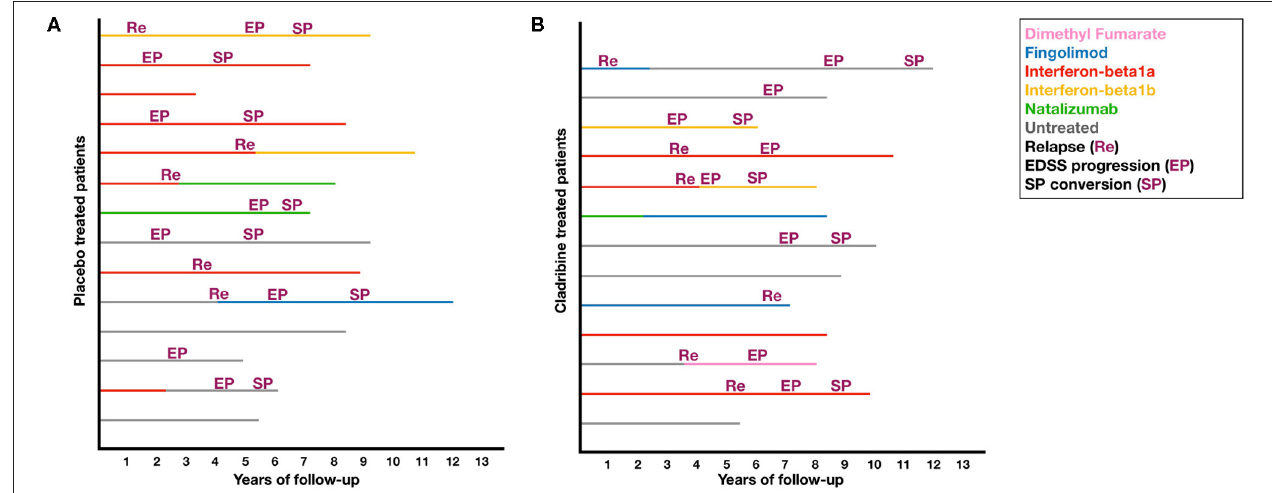
FIGURE 1 | Post-trial treatments and study outcomes. Plots shows post-trial treatments and study outcomes in placebo (A) and cladribine-treated patients (B) .